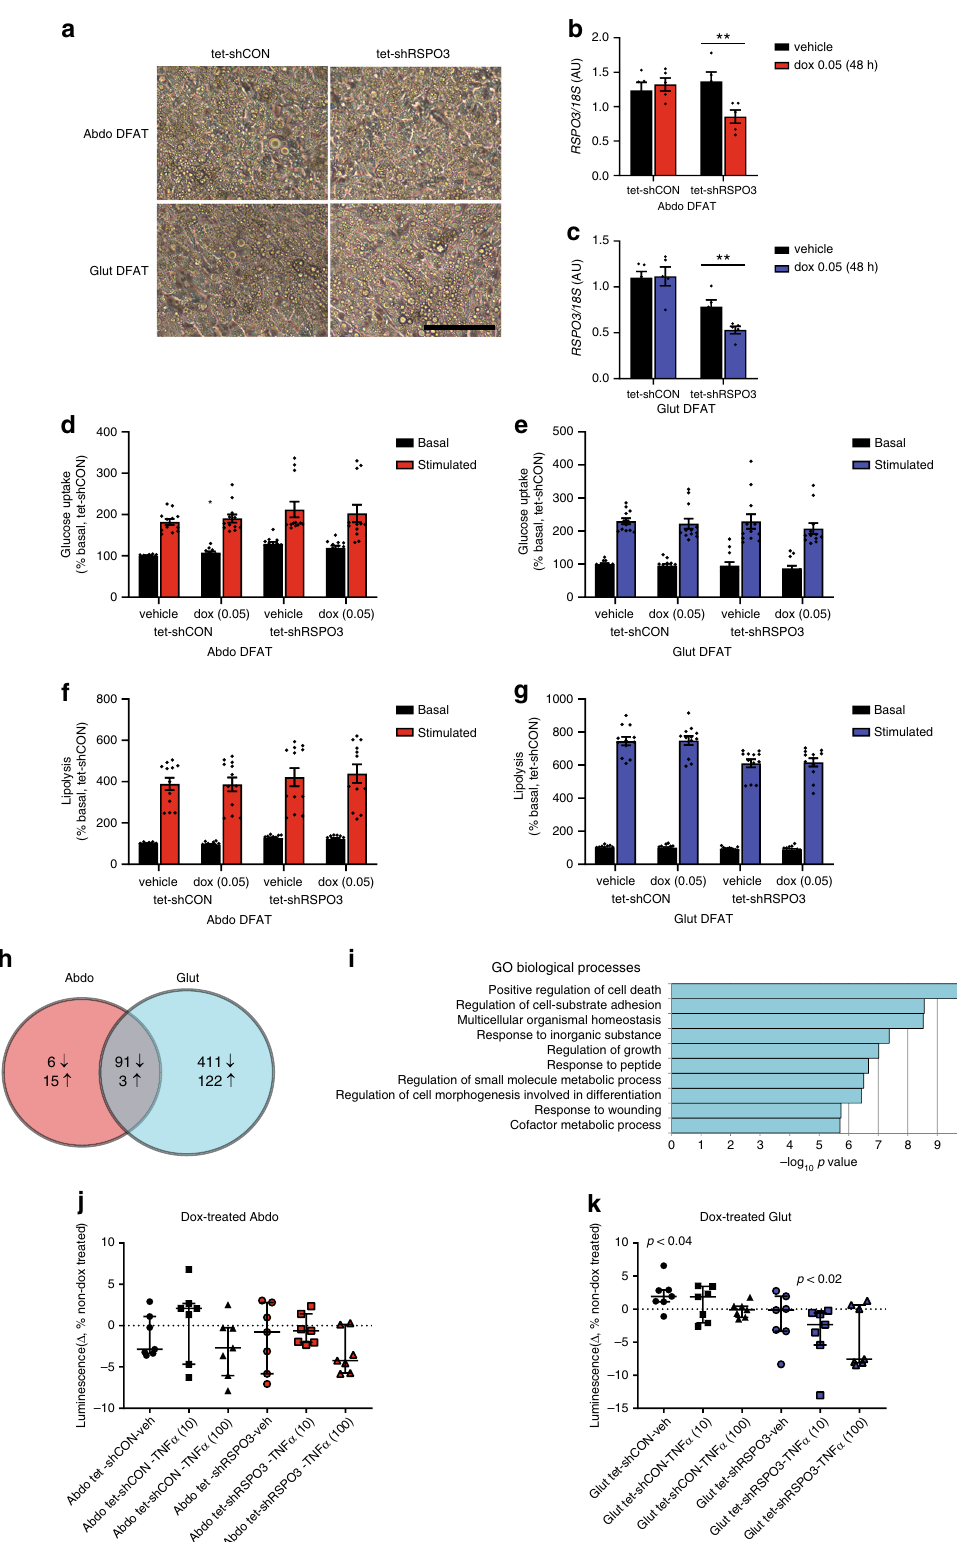
expression and AEI data we hypothesise that the sexually dimorphic pattern of WHRadjBMI associations observed at the RSPO3 locus, with stronger effects in females, stems from the lower baseline RSPO3 expression in female SC AT. Our AEI analyses and collective fi ndings also support a model whereby